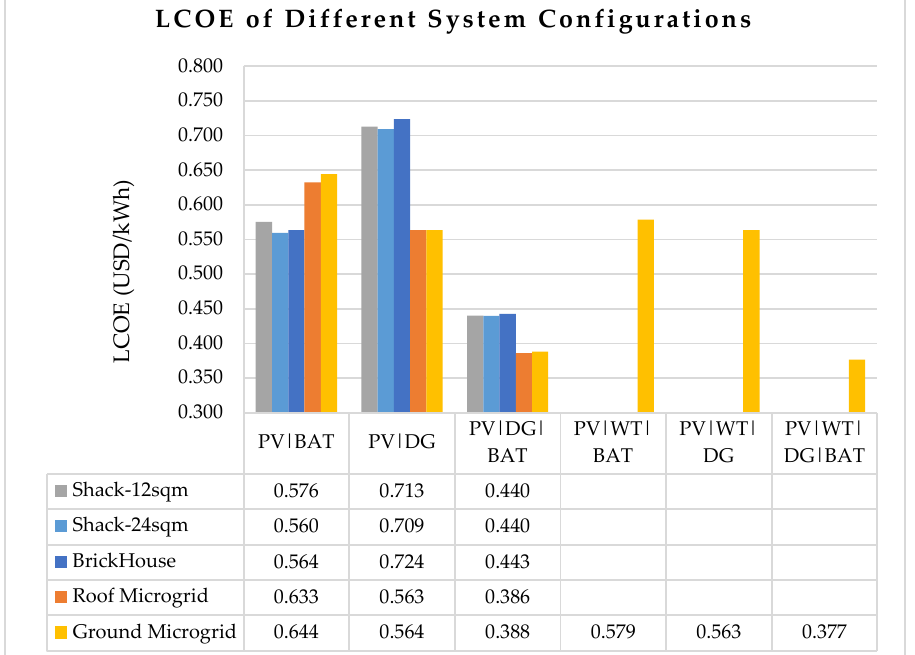
Figure 16. Impact of fuel price change on system costs.